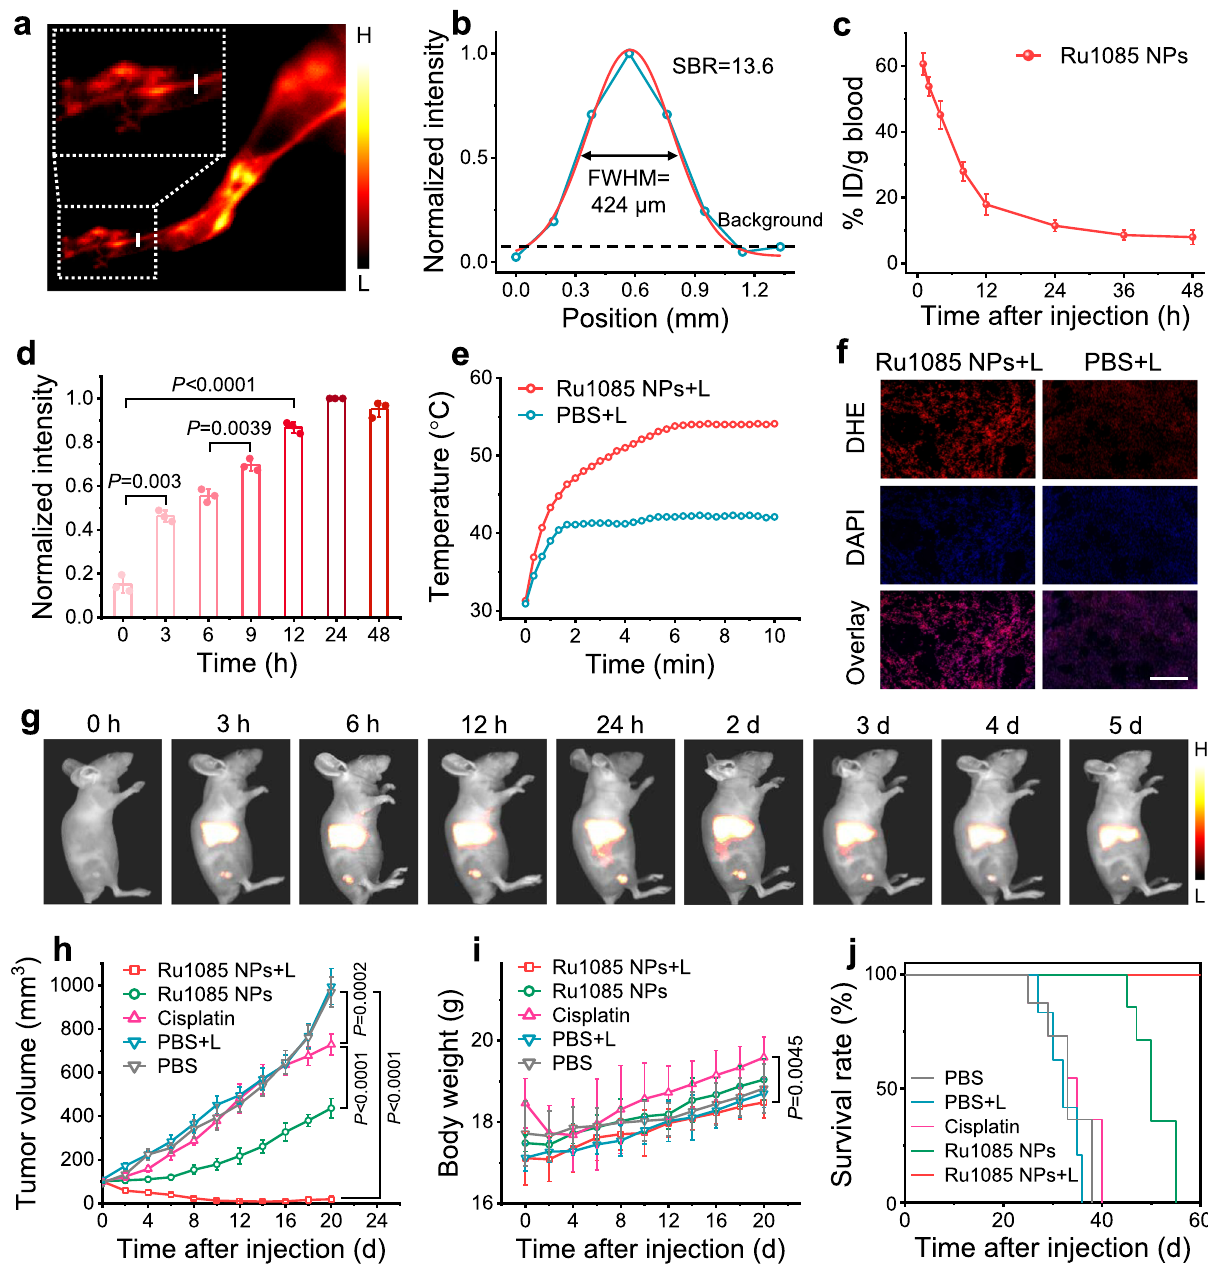
Fig. 6 In vivo NIR-II fl uorescence imaging and chemo-phototherapeutic effect of Ru1085 NPs in A549 tumor-bearing mice. a NIR-II fl uorescence images of hindlimb vessels after intravenous injection of Ru1085 NPs. b NIR-II fl uorescence intensity pro fi les (blue line) and Gaussian fi t (red line) along the white full line in ( a ). c Blood retention and d analysis of NIR-II fl uorescence signals in tumor regions after injection of Ru1085 NPs. Data were presented as mean ± s.d. ( n = 3 independent mice). e Temperature change in tumor region with 808 nm laser illumination (0.8 W cm − 2 , 10 min) at 24 h post- injection of Ru1085 NPs or PBS. f DHE and DAPI staining of tumor slices. Scale bar, 400 μ m. g In vivo NIR-II fl uorescence images of tumor models after injection of Ru1085 NPs. h Tumor inhibitory effect and i mice body weight of tumor models within 20 days of treatment. j Kaplan – Meier survival plots for various treated mice ( Ru1085 NPs dose: 1 mg Ru/kg, cisplatin dose: 1 mg Pt/kg, laser treatments: 0.8 W cm − 2 for 10 min). Data were presented as mean ± s.d. ( n = 5 independent mice). Statistical differences were analyzed by Student ’ s two-sided t -test. Source data are provided in Source Data fi